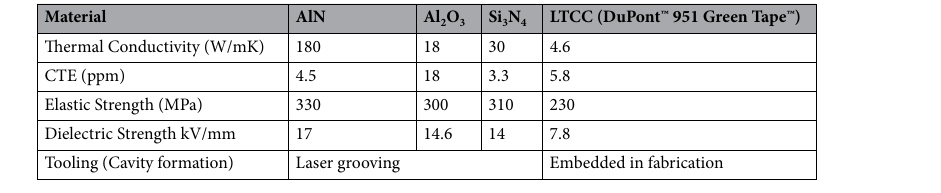
Table 2. Ceramic material